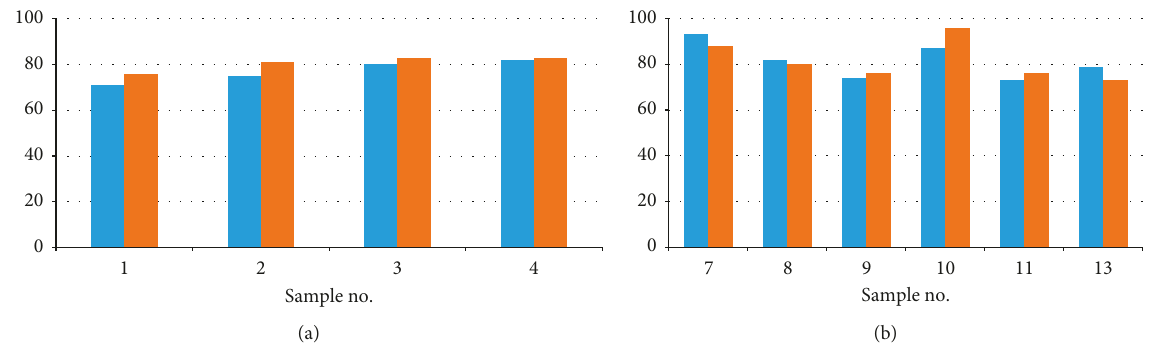
Figure 2: Stabilities of samples modified at 190 ° C (a) and 220 ° C (b).